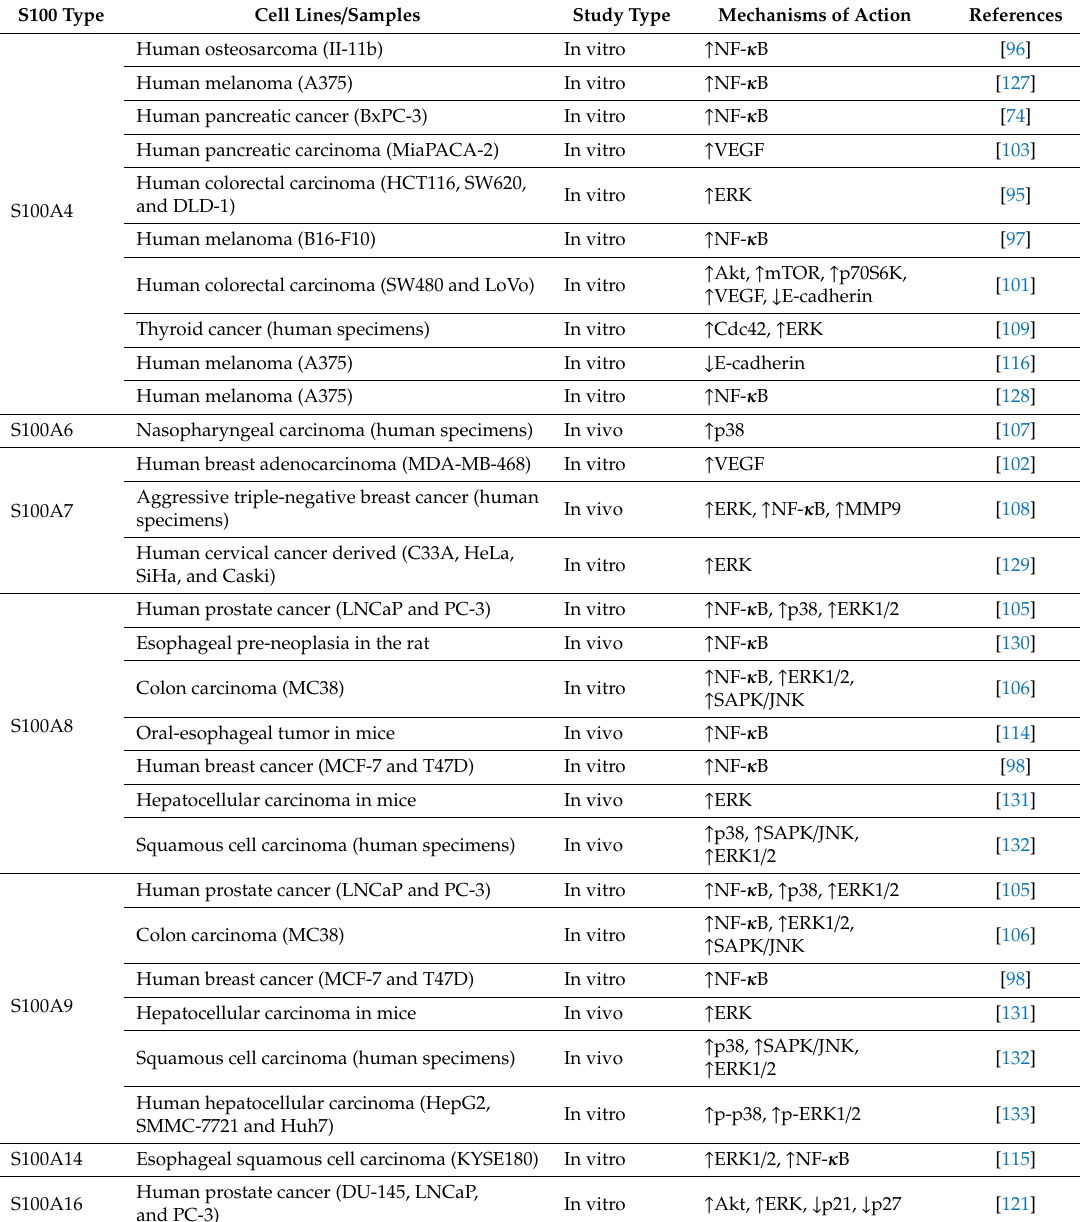
Table 3. Role of the S100 family-receptor for advanced glycation end product (RAGE) axis in cancer